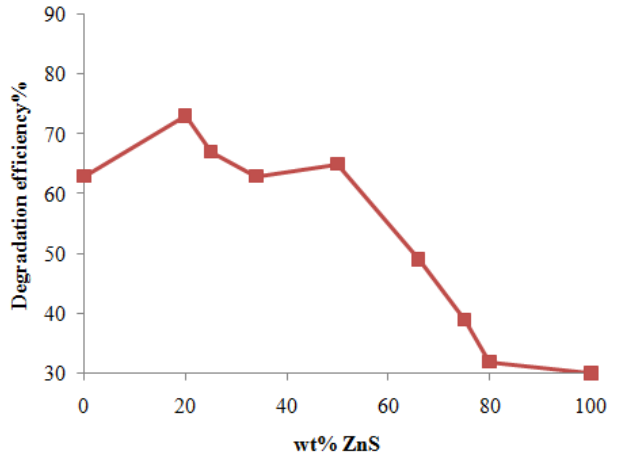
Figure 11. Degradation efficiency of MB in the presence of physical mixtures of ZnS and CdS.